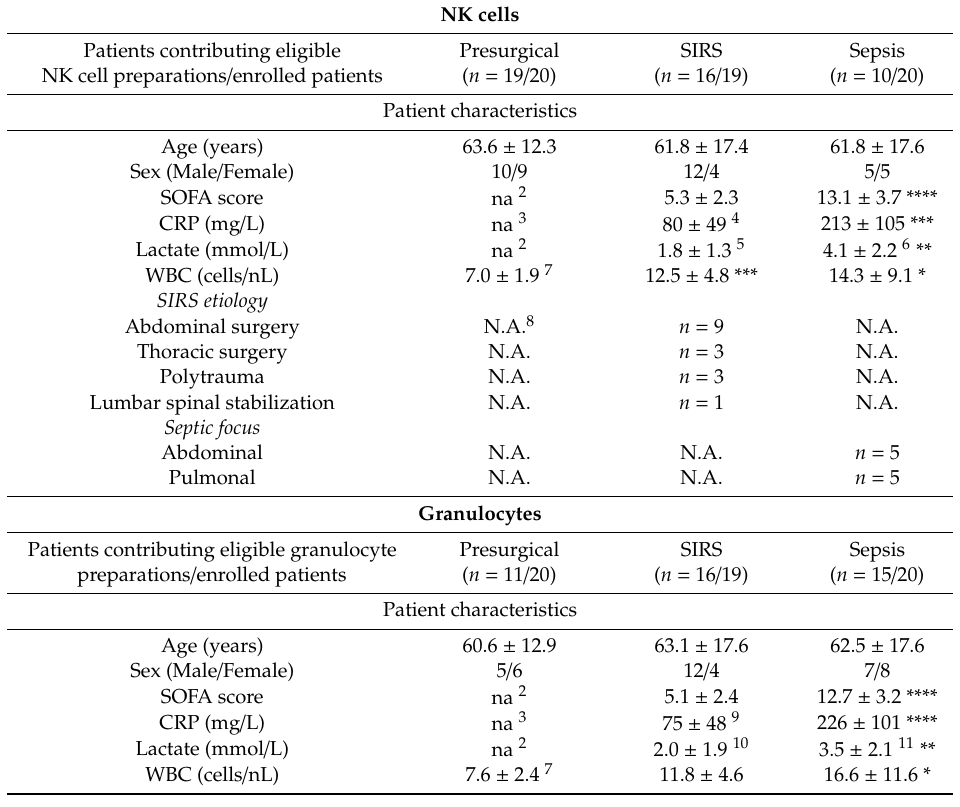
Table 1. Patient characteristics for NK cells and granulocytes for the discovery set 1